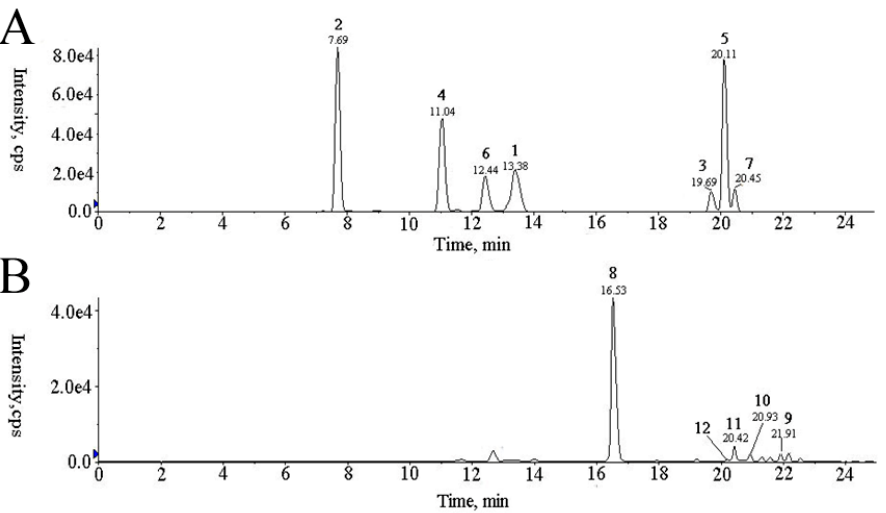
Figure 2. MRM chromatograms in ( A ) positive and ( B ) negative modes. Identification: 1, calycosin; 2,